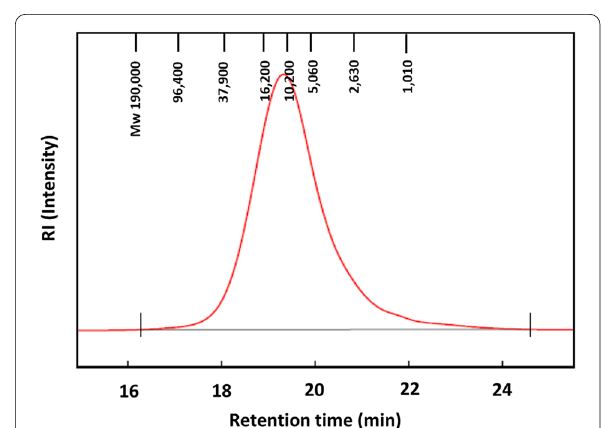
Fig. 5 Molecular mass distribution of the purified sample from A. zerumbet aqueous extracts (red line). The red line indicates the molecular mass